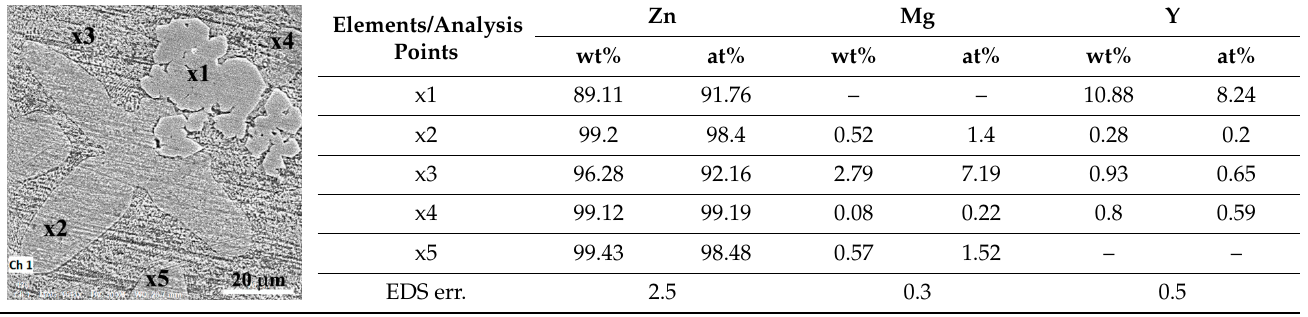
Table 2. Chemical compositions of the samples (average values from five determinations).